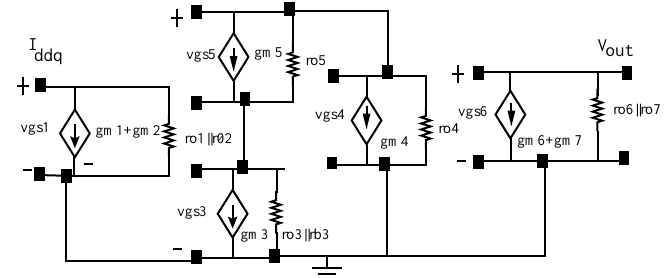
Figure 12. Small Signal model of the proposed